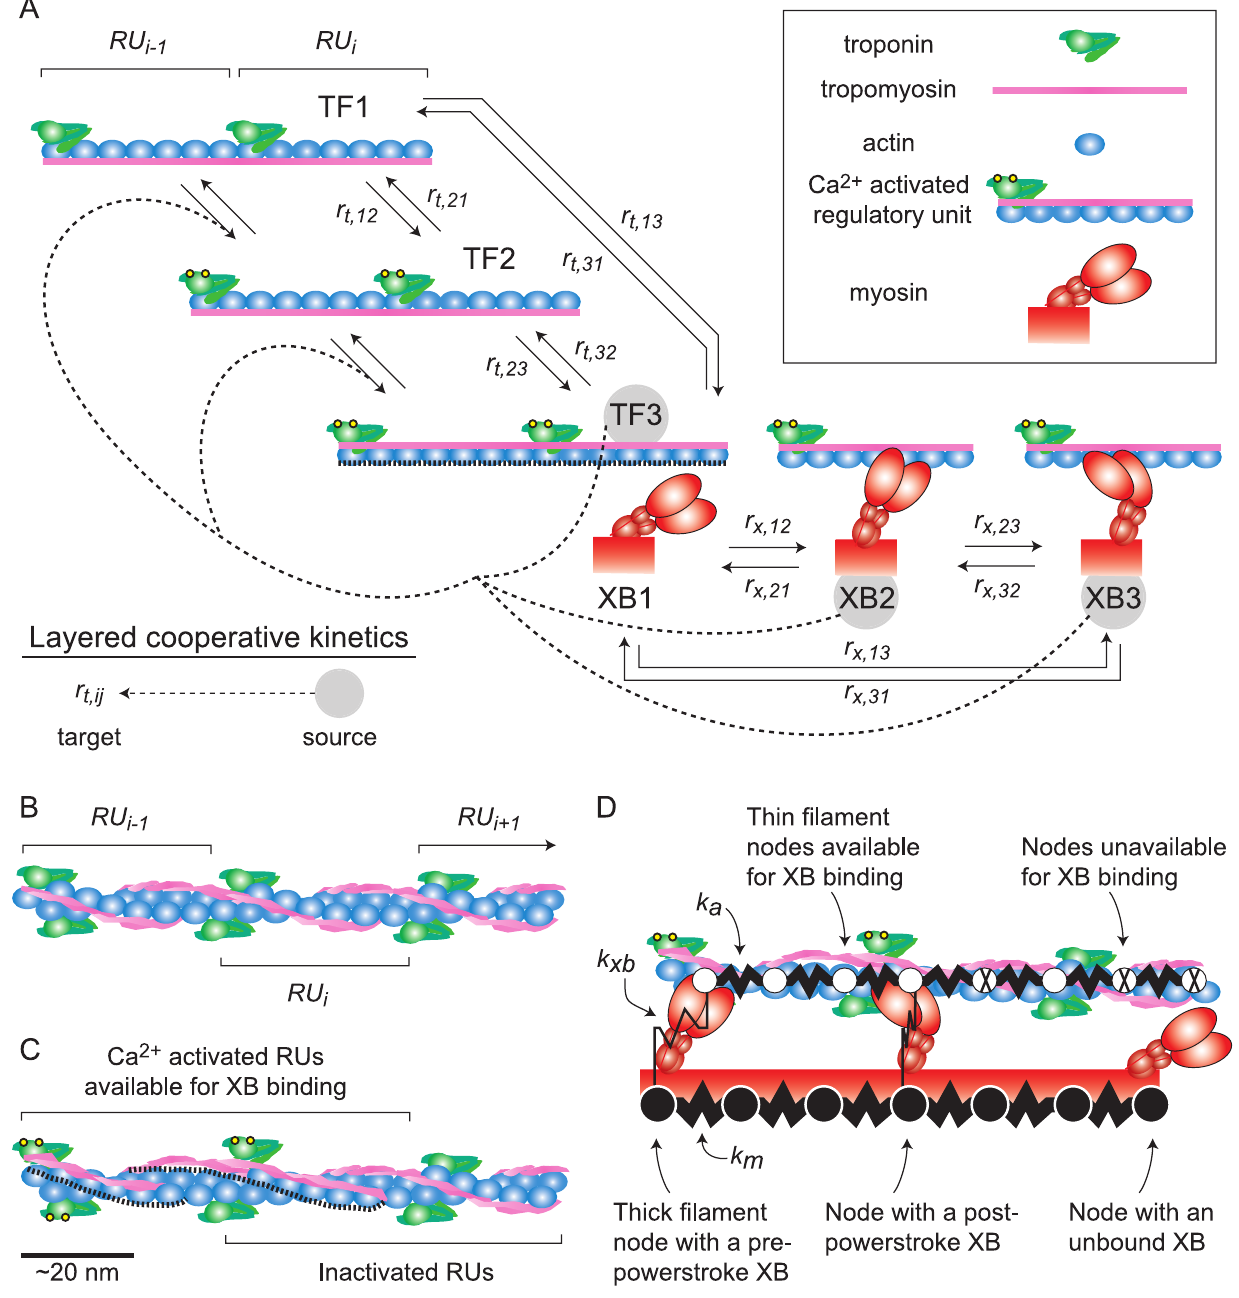
Figure 1. Kinetic forms of cooperativity are layered upon basic model kinetics. (A) Basic model kinetics combine two three-state cycles describing thin filament regulatory unit (RU) activation and cross-bridge (XB) binding [27]. Thin filament transition rates ( r t,ij ) between states TF1–TF3 represent spatial and kinetic behaviors consistent with troponin binding Ca 2 + and tropomyosin movement to activate RUs, which allows myosin binding to actin. Dashed lines between TF2 and TF3, illustrate exposure of available binding sites along the thin filament. XB transition rates ( r x,ij ) are strain dependent between states XB1–XB3, representing transitions between unbound, bound pre-power stroke, and bound post-power stroke states. Cooperative pathways (dashed arrows) are layered upon basic model kinetics, amplifying thin filament activation kinetics at neighboring RUs. These layered, kinetic forms of cooperativity represent potential pathways where activation (TF3) or XB binding (XB2 or XB3) can act as a source of cooperativity to augment RU activation kinetics at neighboring RUs via targets r t,12 or r t,23 . (B) Adjacent RUs run along each of the helices that compose the thin filament. Thus, adjacent RUs along one helix face opposing thick filaments every , 37 nm. Consistently, adjacent co-linear interactions between a thick and thin filament pair occur on alternate helices of the thin filament. (C) Therefore, certain regions of the thin filament can have RUs activated on both helices, either of the two helices, or neither of the two helices. (D) Similar to a finite element models, mechanics are simulated using a network of linear springs where forces balance at thick and thin filament nodes each time-step. The mechanical network comprises tunable spring constants k m , k a , and k xb , representing thick filament, thin filament, and myosin XB stiffness, respectively. Potential interactions for a co-linear thick and thin filament pair depict available thin filament nodes as shown in panel C. Those XBs extending from thick filament nodes occupy the co-linear plane, while XBs extending from neighboring thick filament nodes (not shown) lie outside of this plane.